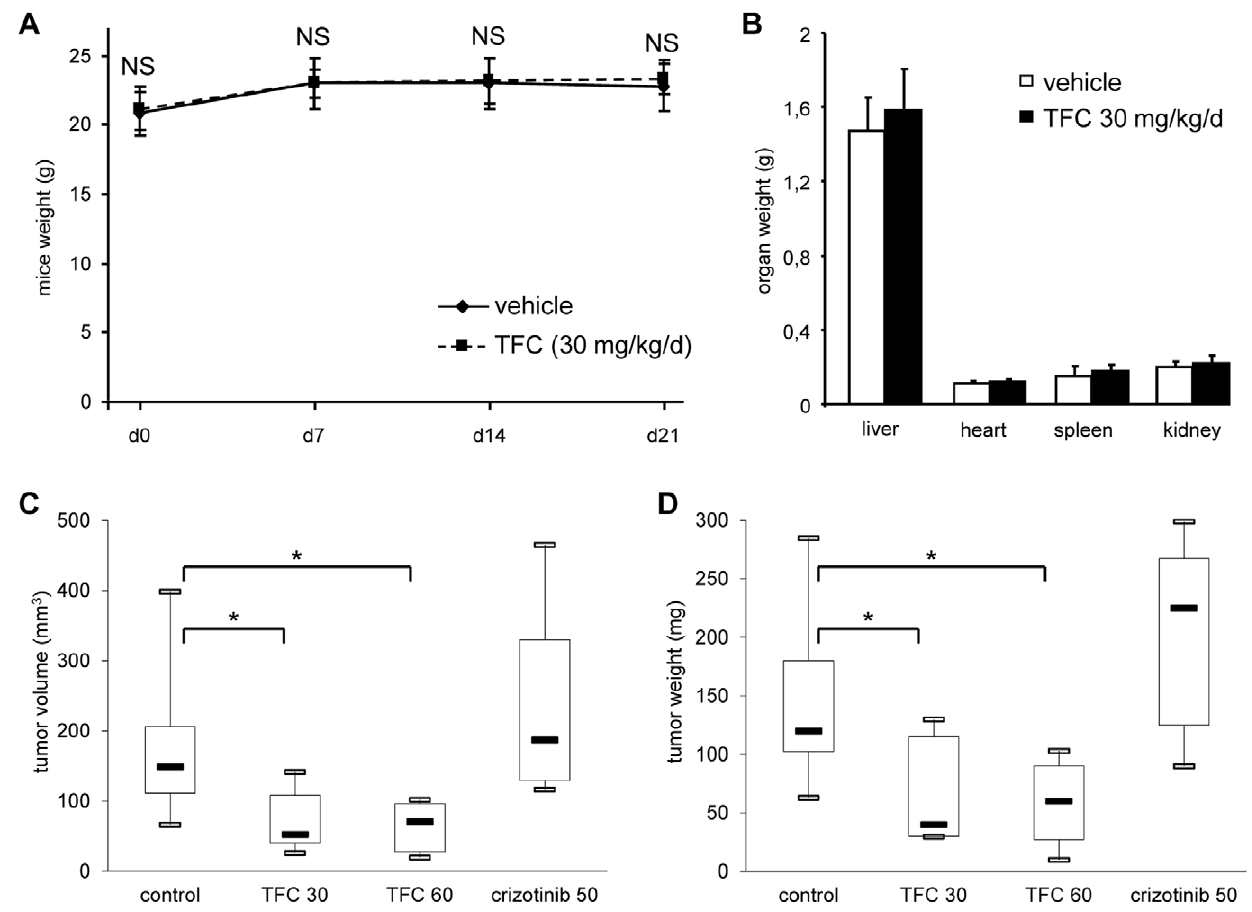
Figure 3. Triflorcas impairs in vivo tumor growth of cancer cells carrying oncogenic Met, without causing major side effects. (A) Evolution of the body weight in mice, treated intra-peritoneally with either vehicle or Triflorcas (TFC; 30 mg.kg 2 1 every day) showed no significant differences. Body weight is expressed as weight evolution over the 21 day-treatment period. (B) The weight of heart, spleen, kidney, and liver was evaluated in mice daily injected with Triflorcas (30 mg.kg 2 1 ) or vehicle for 21 days. No significant differences were observed. Values are expressed as means 6 s.e.m. P . 0.05. (C and D) Triflorcas treatment (i.p. 30 and 60 mg.kg 2 1 every other day) reduced tumor volume (C) and weight (D) in nude mice injected sub-cutaneously with H1437 cells. Crizotinib (50 mg.kg 2 1 daily) did not impair tumor growth. Values are reported as boxplots and expressed as means 6 s.e.m. * P , 0.05; Student- t test.